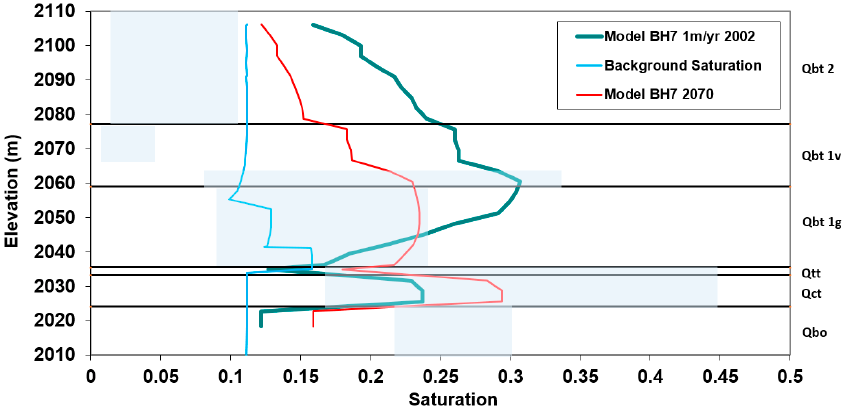
Figure 15. Simulated saturations versus depth for the background flow field and at years 2002 and 2070.